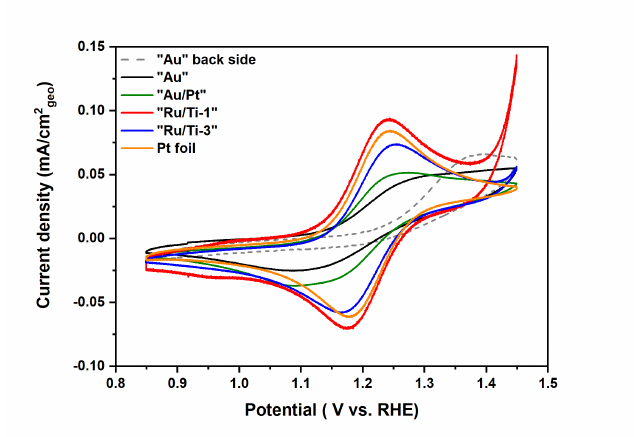
Figure 22. Cyclic voltammograms of all investigated samples obtained at a scan rate of 20 mV/s in a solution containing 1 mM K 4 [ Fe ( CN ) 6 ] in 0.1 M